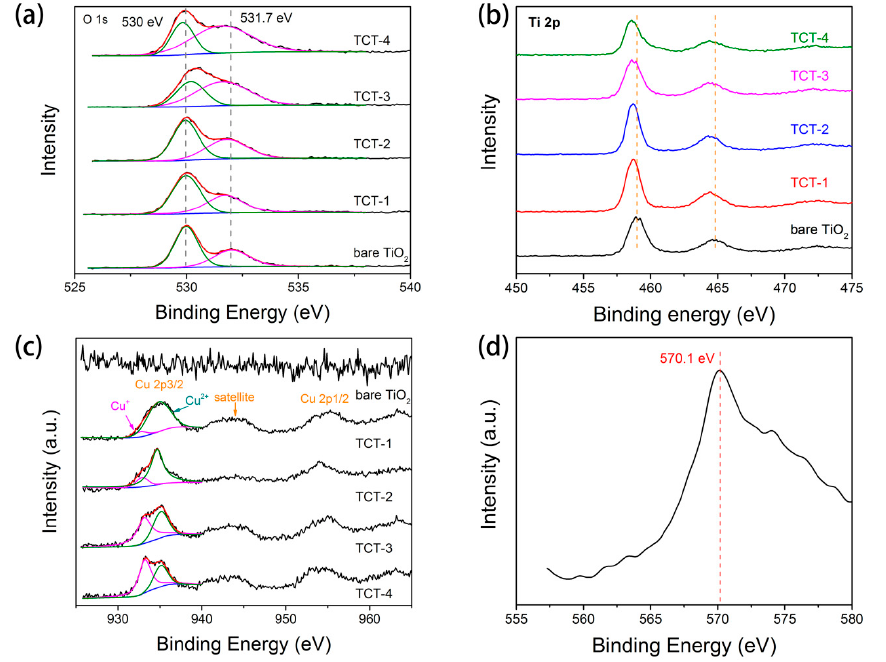
Figure 4. ( a ) O 1s; ( b ) Ti 2p; and ( c ) Cu 2p XPS spectra of bare TiO 2 and TCT samples; and ( d )